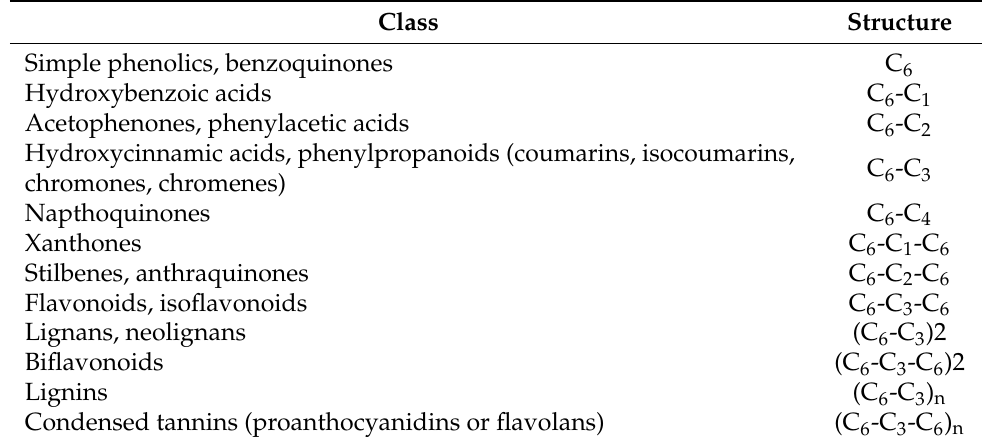
Table 1. Classes of phenolic compounds in plants